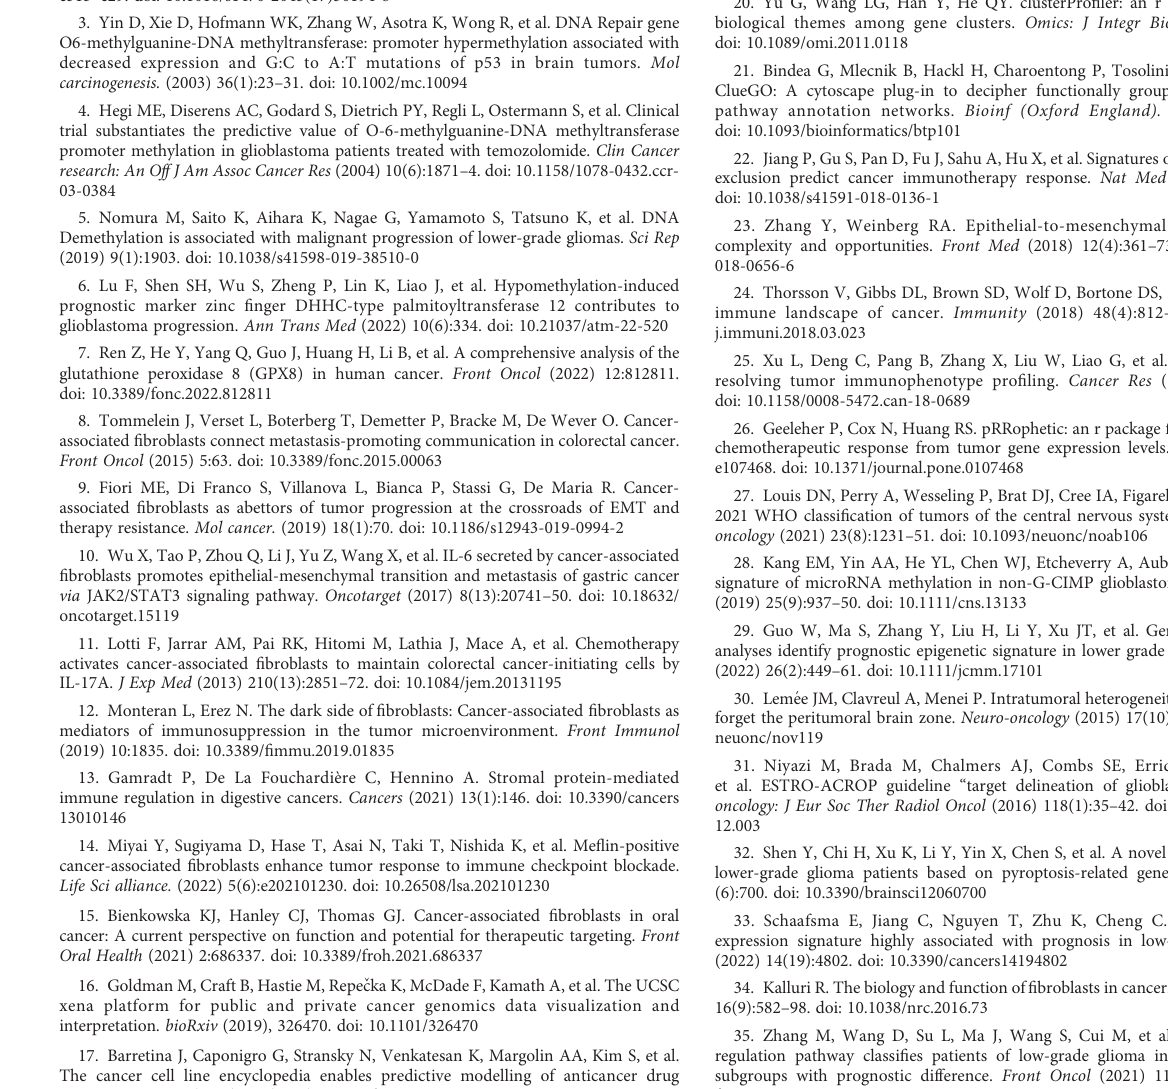
SUPPLEMENTARY TABLE 2 Clinical characteristics of patient cohort. SUPPLEMENTARY TABLE 3 DEGs in TCGA.